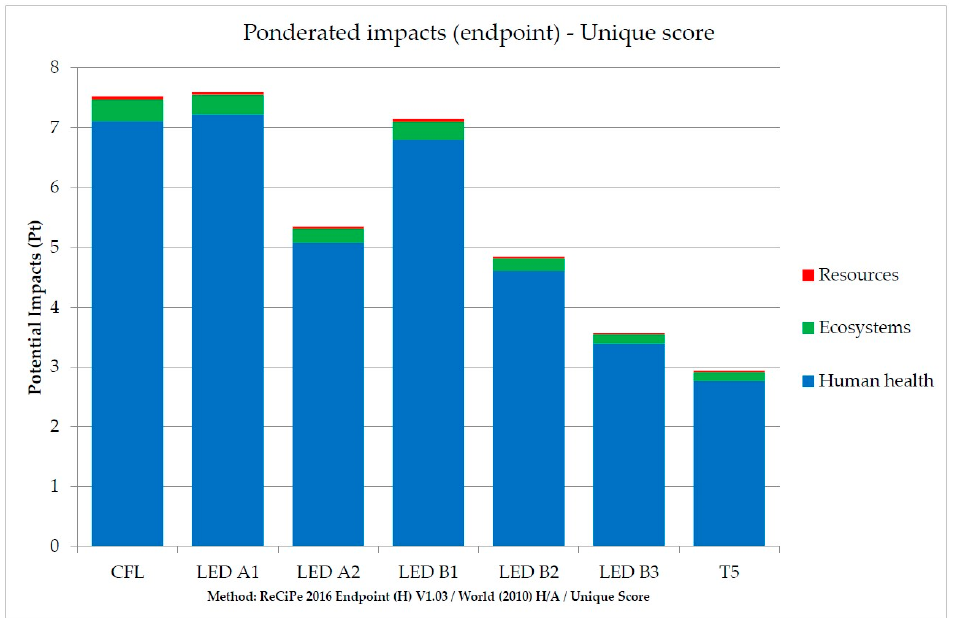
Figure 6. Endpoint potential impacts of lighting systems.